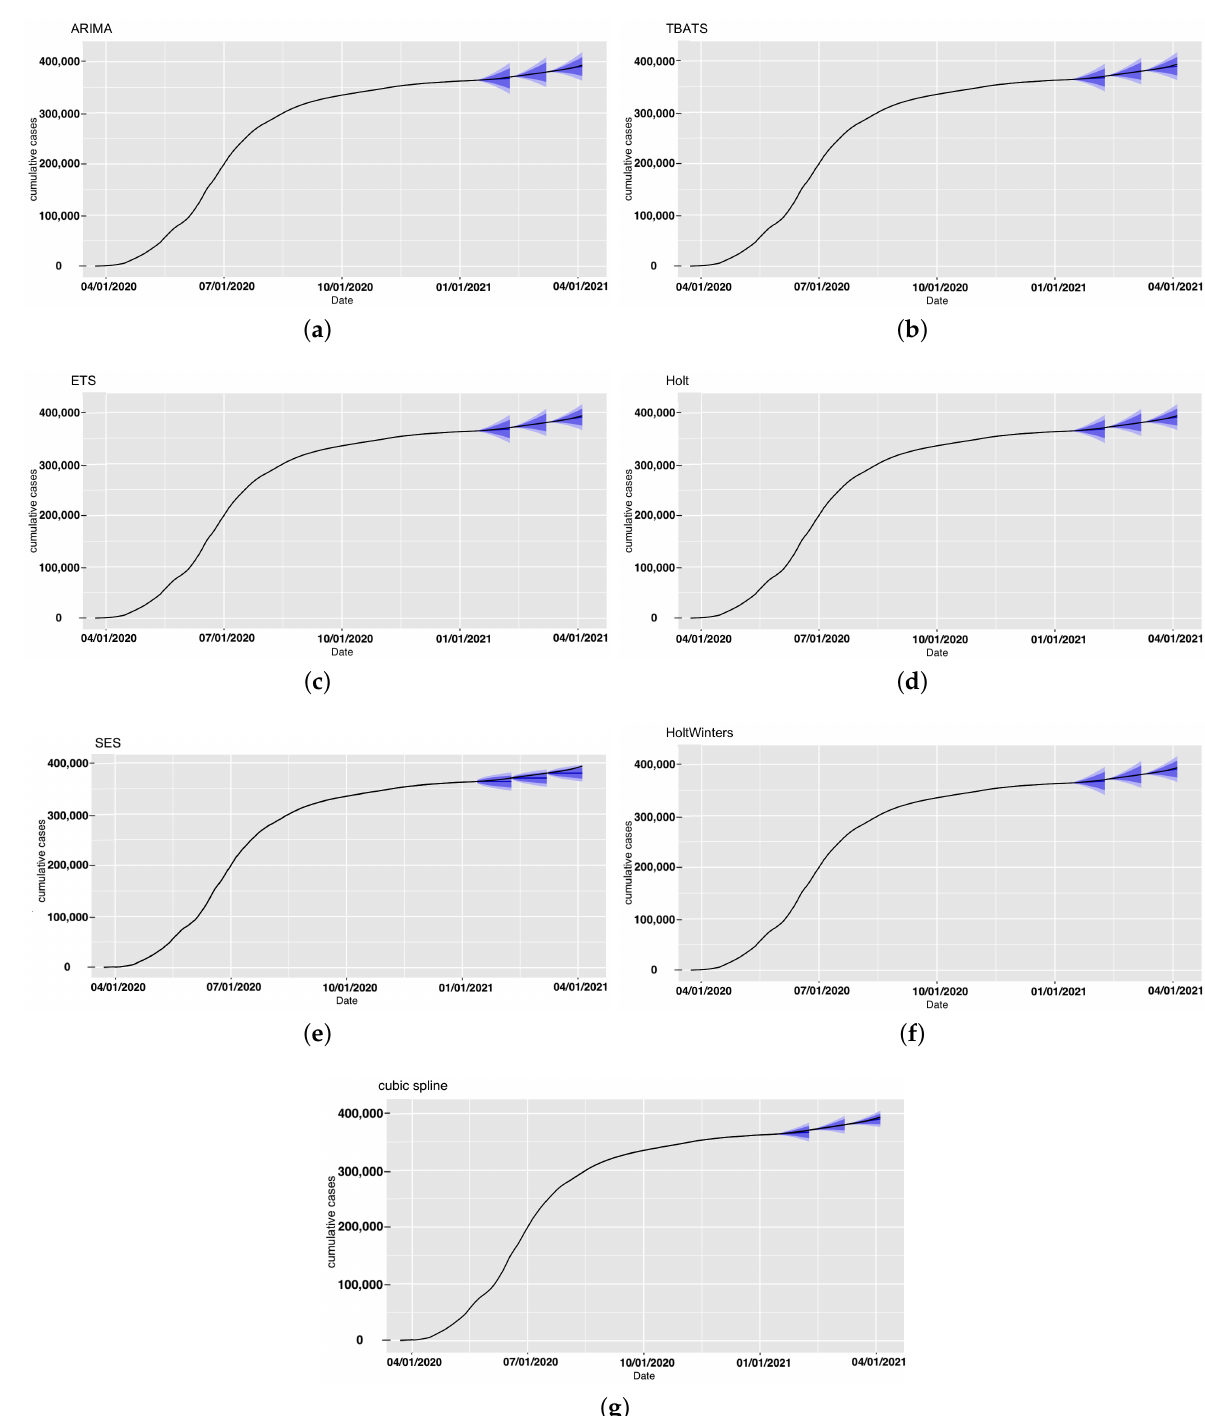
Figure 3. Forecast confirmed cases in Saudi Arabia for all models with the prediction intervals (in blue). ( a ) ARIMA, ( b ) TBATS, ( c ) ETS, ( d ) Holt, ( e ) SES, ( f ) HoltWinters, and ( g ) cubic